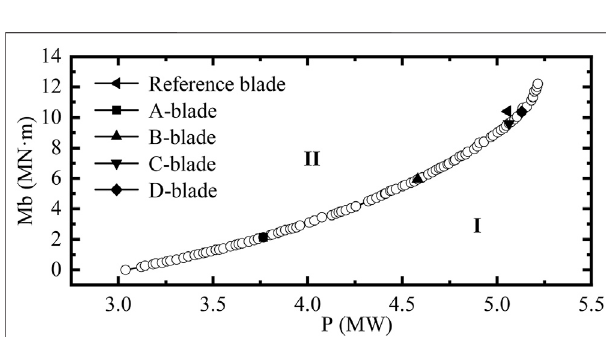
FIGURE 8 | The two-objective optimization results.